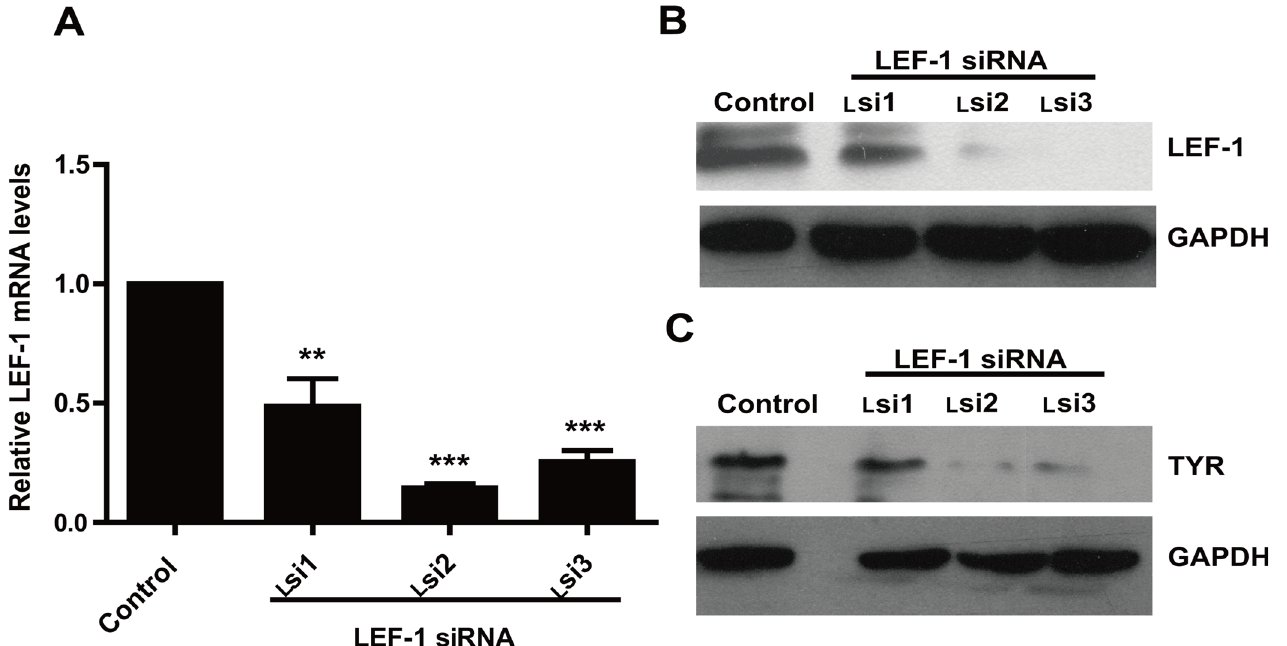
Fig 1. LEF-1 mRNA and LEF-1 and TYR protein levels in LEF-1 specific siRNA-transfected UACC903 cells. A , RT-qPCR data showed that transfection with LEF-1 specific siRNAs led to a significant decrease in LEF-1 expression compared to the control group, especially Lsi1 and Lsi2. An asterisk indicated statistical significance ( ** p < 0.01, *** p < 0.001 by unpaired t-test). B, C Western blotting was performed to examine LEF-1 and TYR protein levels in each group using a ChIP Ab+ LEF-1 mouse monoclonal antibody or anti-TYR mouse monoclonal antibody, respectively. GAPDH was used as an internal